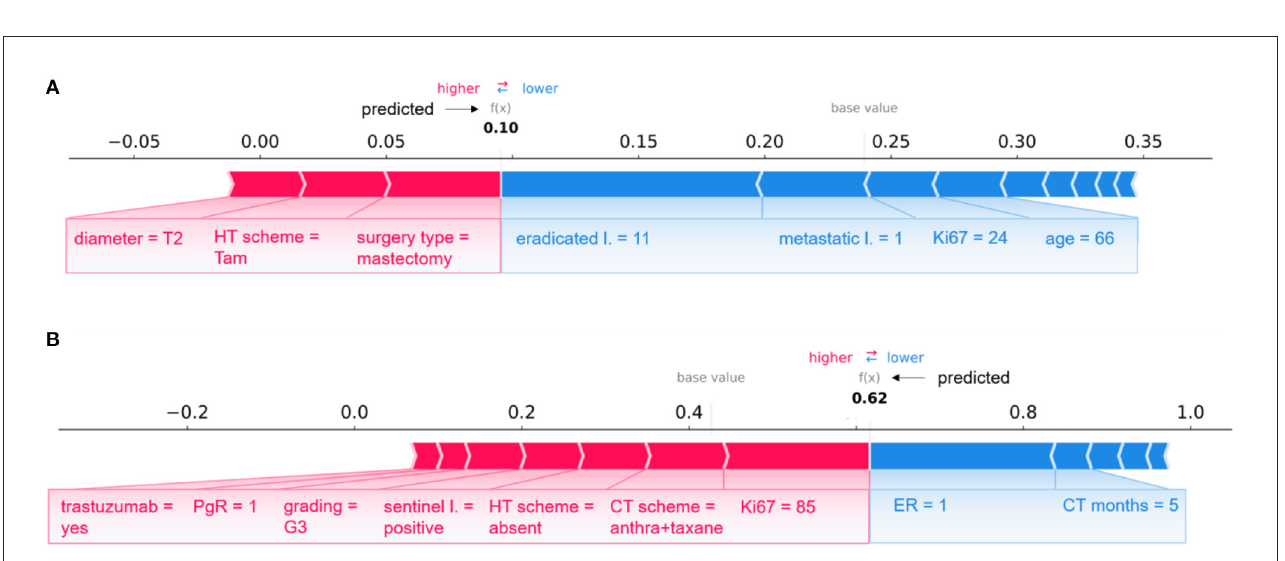
FIGURE6 Examples of individual explanations for correctly classified patients. (A) A non-IDE patient for the 5-year predictive model and (B) an IDE patient for the 10-year predictive model. (A, B) Representation of the additive Shapley values: red color indicates a positive contributions, while blue a negative